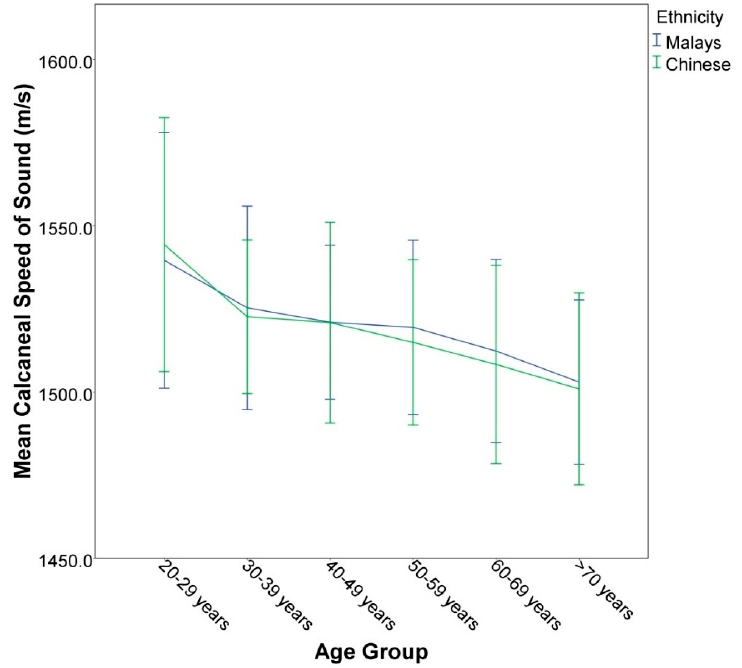
Figure 1. The age-trend of SOS between Chinese and Malay men in